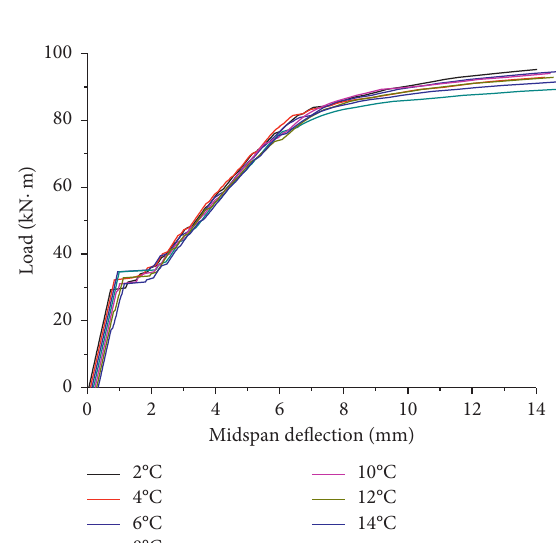
Figure 28: Stress nephogram.